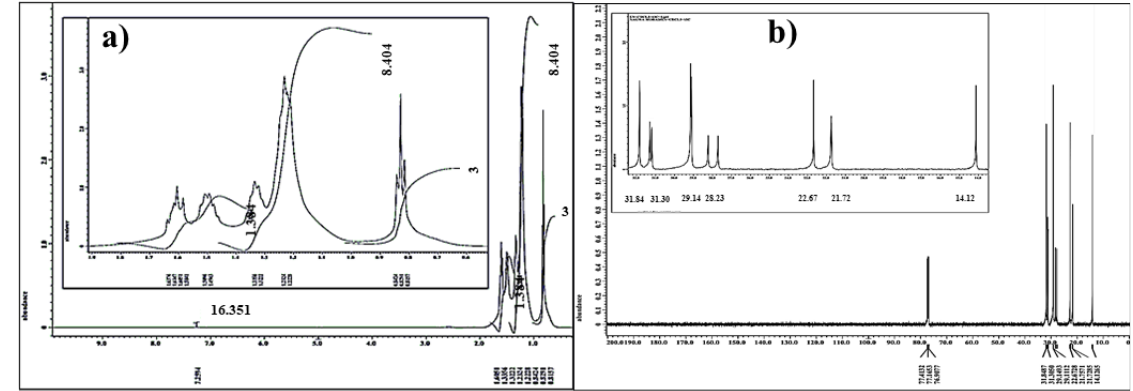
Figure 2. ( a ) 1 H–NMR spectrum; ( b ) 13 C–NMR spectrum of HTIP chelating ligand.